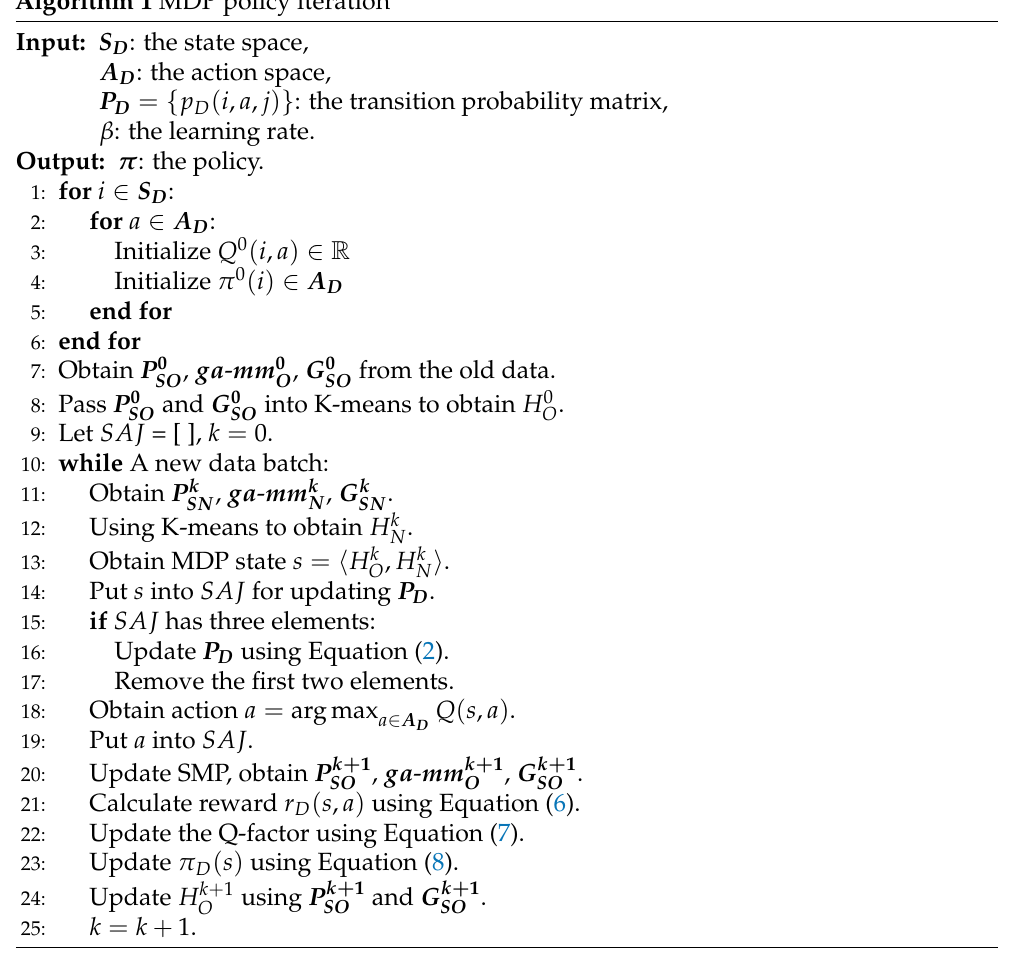
Algorithm 1 MDP policy